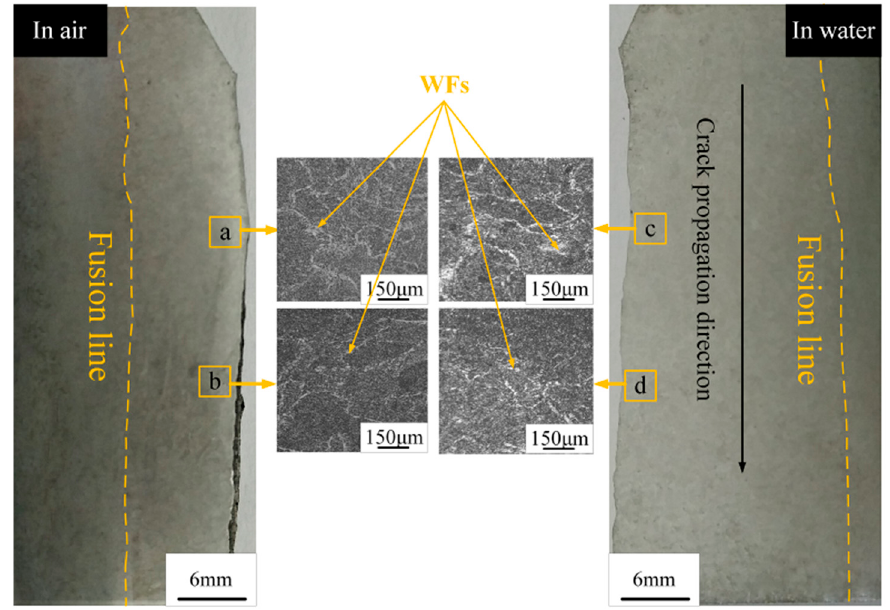
Figure 9. Metallographic structures of the side surface near the crack path both in air and water; ( a , b ) are EBSD testing regions in air, where, the ∆ K equal s to 45 and 60 MPa·m 1/2 , respectively. ( c , d ) are EBSD testing regions in water, where, the ∆ K equal s to 45 and 60 MPa·m 1/2 , respectively.